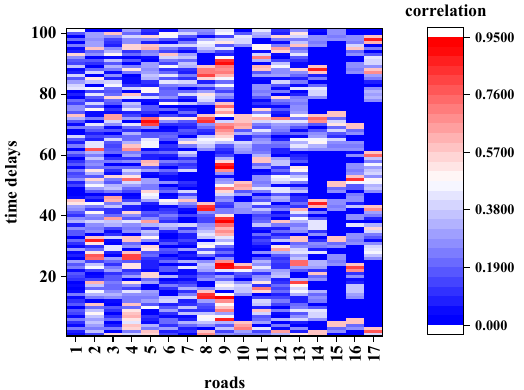
Figure 9. Correlation determined using the original CCF.